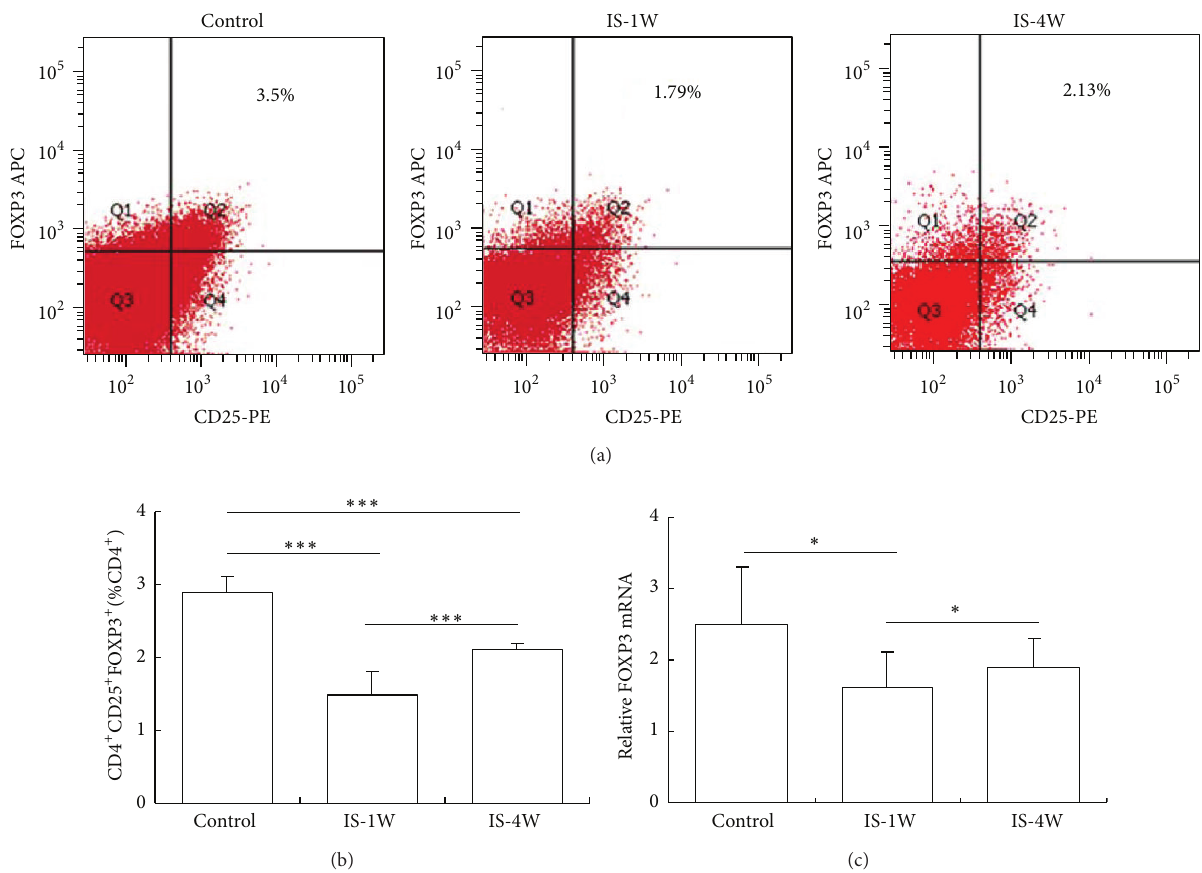
Figure 3: The proportion of CD4 + CD25 + FOXP3 + Tregs was reduced in IS patients. (a) Representative results from the FCM analysis of the samples obtained from control subjects and IS patients. The percentage of CD4 + CD25 + FOXP3 + T (Treg) cells among the total CD4 + T cell population is indicated. (b) Statistical analysis of the results obtained from the FACS analysis of the samples from 30 control subjects and 50 IS patients at 7 and 28 days after stroke. (c) The FOXP3 mRNA expression levels in the PBMCs obtained from various groups were analyzed using real-time PCR, and the values were normalized to GAPDH. ∗ 𝑃 < 0.05 and ∗∗∗ 𝑃 < 0.001 , compared with the controls. IS-1W = 1 week after IS; IS-4W = 4 weeks after